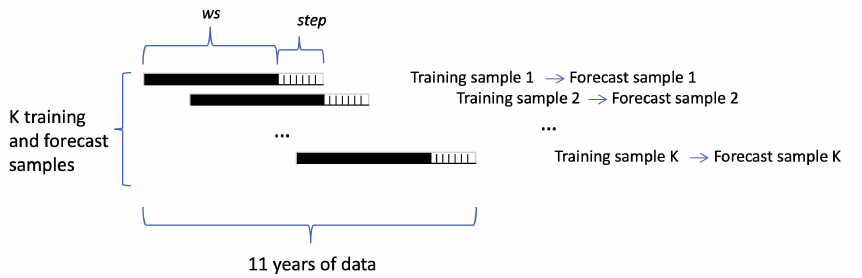
Figure 1. Sampling Scheme. The forecast and investment strategy are evaluated using a rolling window scheme. For each training window ws it follows a forecast for the next step days using one-step ahead forecasts. The process is repeated K times by shifting the training and testing samples step days ahead every